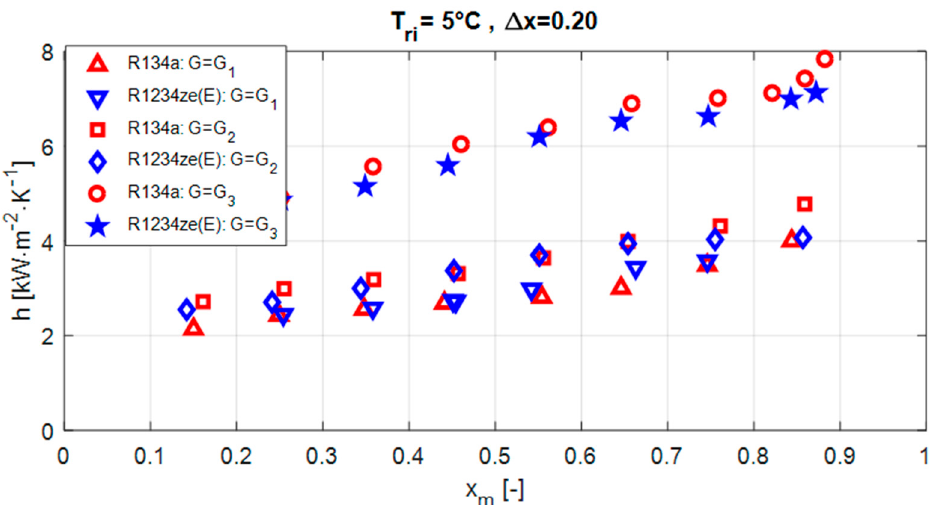
Figure 5. Effect of the mean quality on the heat transfer coefficient for different mass fluxes (G 1 = 80 kg · m − 2 · s − 1 , G 2 = 110 kg · m − 2 · s − 1 , G 3 = 220 kg · m − 2 · s − 1 ).